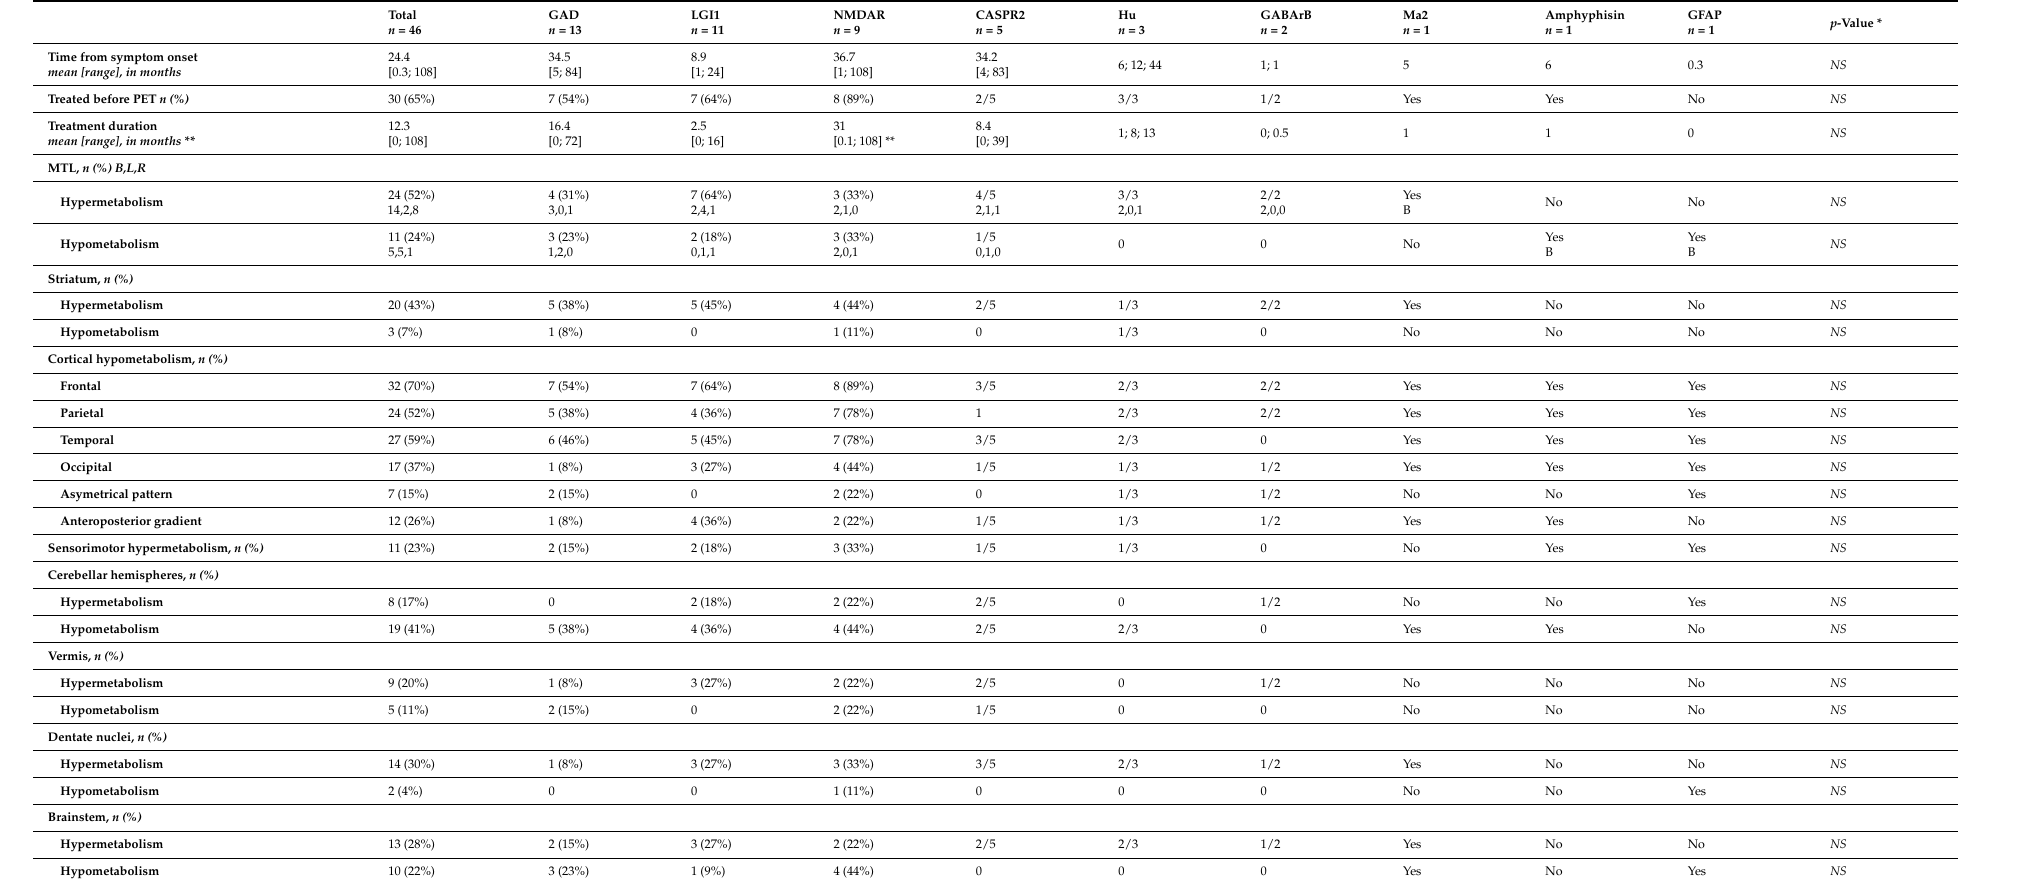
Table 2. Brain FDG PET results in the whole cohort and across autoantibody